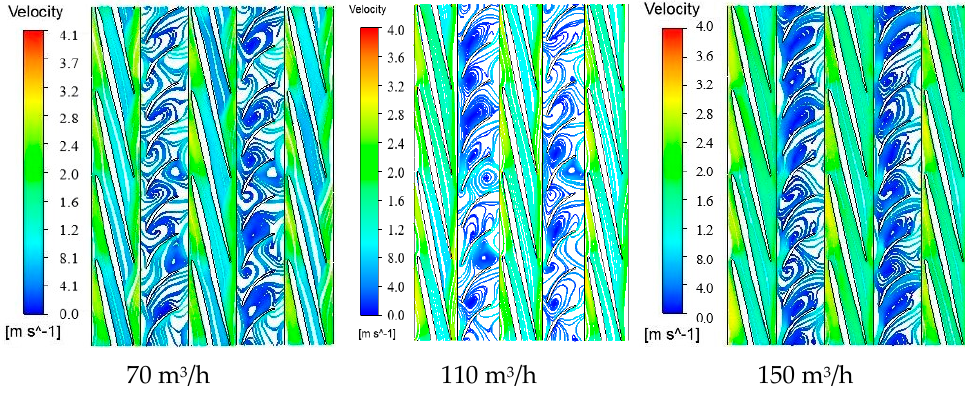
Figure 9. The streamline distribution at 0.2 blade height of multiphase pump pressurizing units.